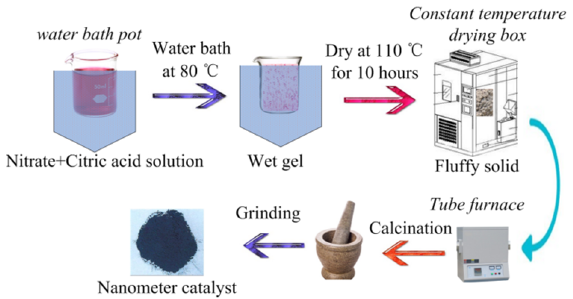
Figure 1. Preparation process route of the catalyst